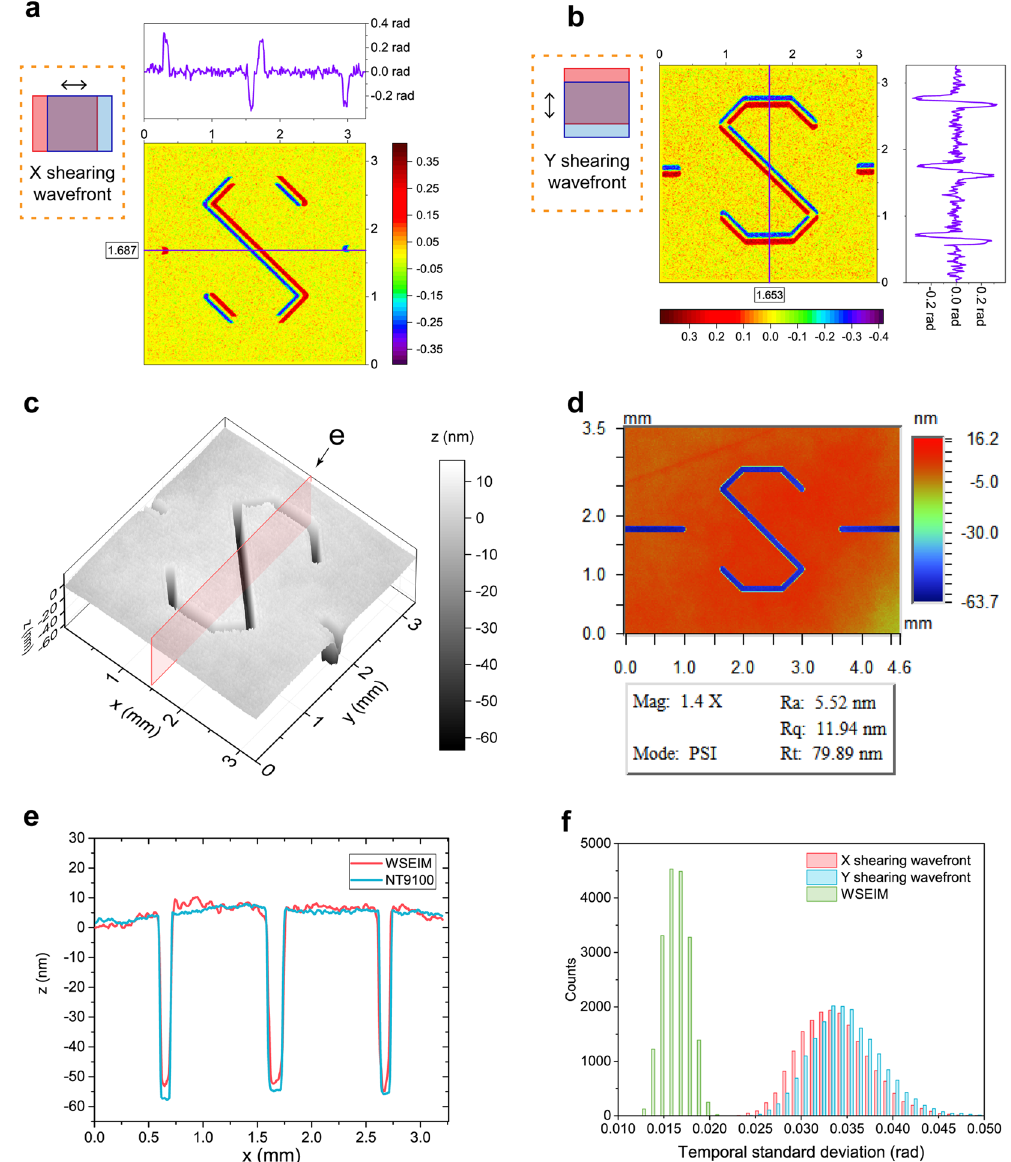
Figure 6. Characterization of etched surface using WSEIM. ( a ) Shearing wavefront in the x direction. The purple line on the top shows the one-dimensional distribution along the line y = 1.687 mm in the center of the x shearing wavefront. ( b ) Shearing wavefront in the y direction. The purple line on the right shows the one- dimensional distribution along the line x = 1.653 mm in the center of the y shearing wavefront. Note that the amplitudes of the shearing wavefronts obtained in ( a ) and ( b ) are both 2-fold larger than that of the original wavefront. ( c ) Profiling result measured by our WSEIM. ( d ) Testing result from the Wyko NT9100 optical profiling system. ( e ) Comparison of the one-dimensional distribution results on the cross section labeled in ( c ) measured by the WSEIM and the Wyko NT9100. ( f ) Histogram of the temporal standard deviation of phase, the shearing wavefronts in the x and y directions are illustrated in red and blue, while the temporal standard deviation of the wavefront retrieved by WSEIM in green is only half of the temporal standard deviation of the shearing